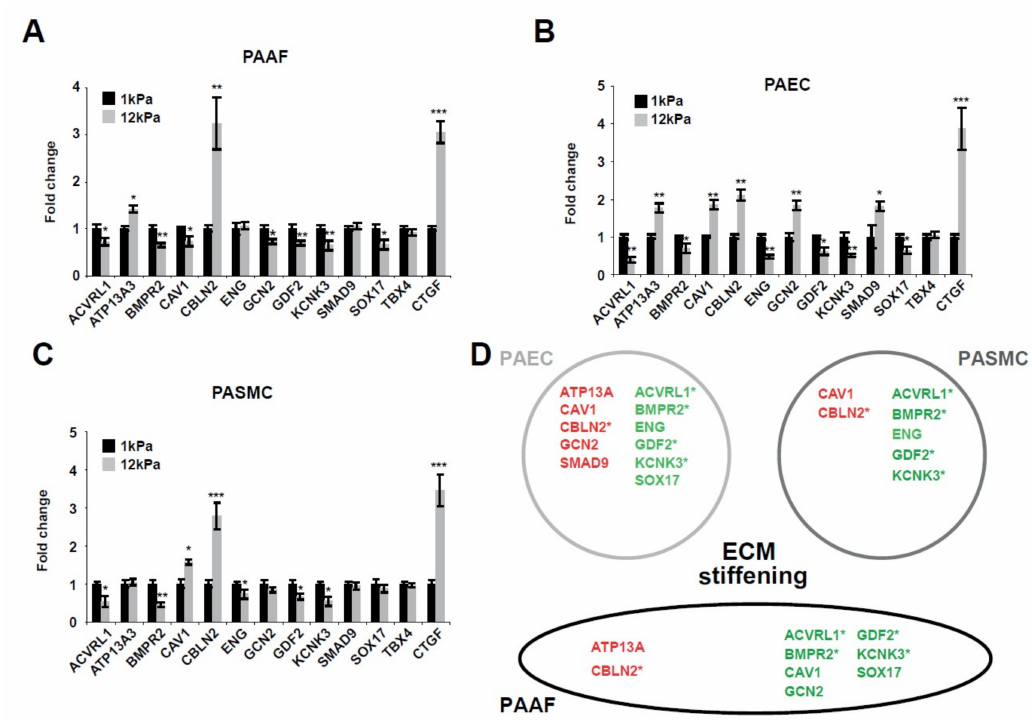
Figure 1. Factors genetically associated with PAH are responsive to matrix stiffening. ( A – C ) Pulmonary arterial cells were plated on soft (1 kPa) or stiff (12 kPa) hydrogel for 48 h. Expression level of factors genetically associated with PAH in PAAFs ( A ), PAECs ( B ), and PASMCs ( C ) were analyzed by RT-qPCR. Mean expression in control groups (1 kPa) was assigned a fold change of 1, to which relevant samples were compared. Data are expressed as mean ± SD (* p < 0.05, ** p < 0.01, *** p < 0.001) of at least three independent experiments. Paired samples were compared using a 2-tailed Student’s t -test. ( D ) Schematic of the main results. Red: upregulated genes; Green: downregulated genes; * denote consistent and significant modulation in the three vascular cell